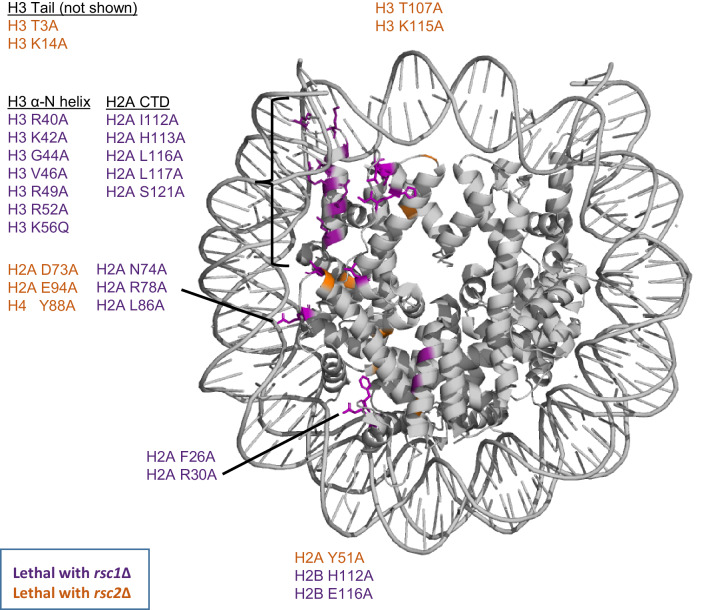
Synthetic lethal mutations in each of the four histones H2A, H2B, H3, and H4 when combined with rsc1∆ or rsc2∆ mutations.Mutations that are specifically lethal in combination with rsc1∆ are colored purple, mutations that are specifically lethal with rsc2∆ are colored orange. PDB code 1ID3.